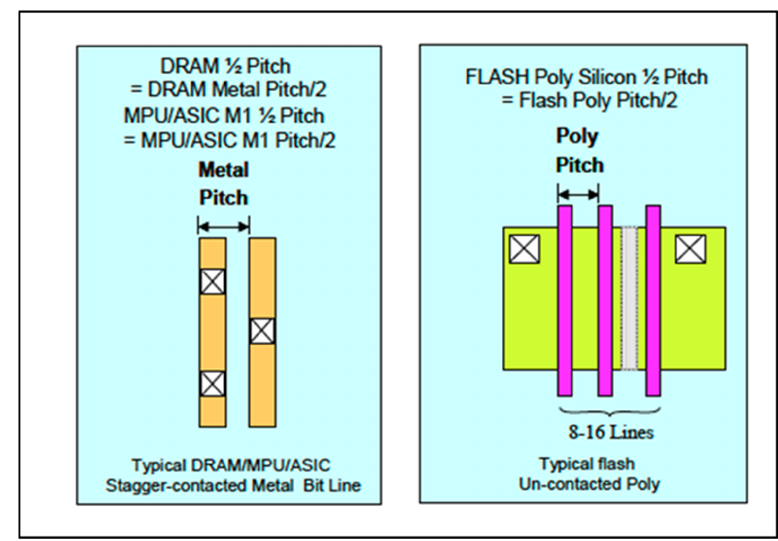
Figure 8. Technology node definition used by the previous Roadmaps.